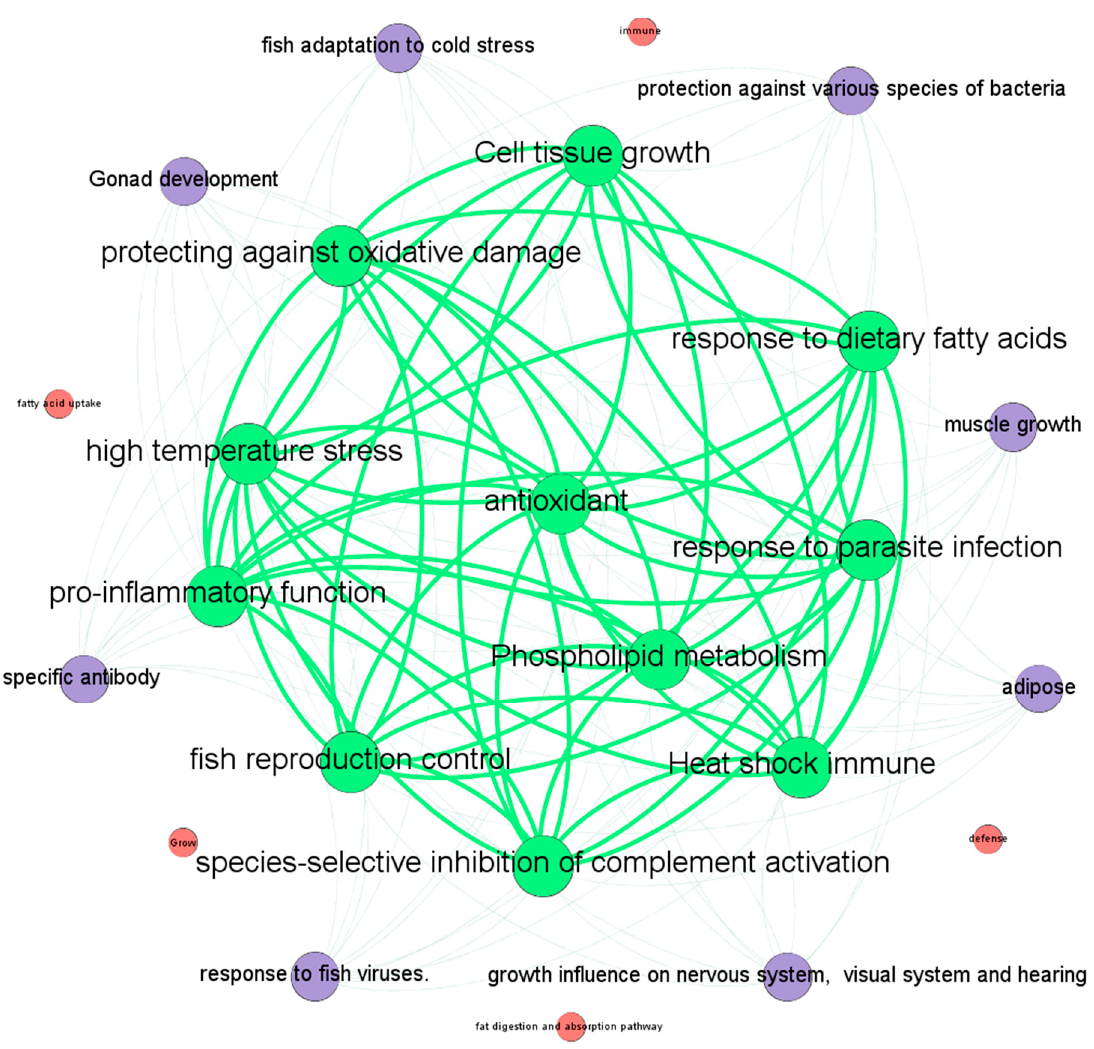
Figure 3. The similarity network between traits, where the nodes represent traits, the weighted edges represent the similarity associations between nodes, the size of a node corresponds to the number of neighbors of the node, and nodes in the network with identical colors have the same similarity value.